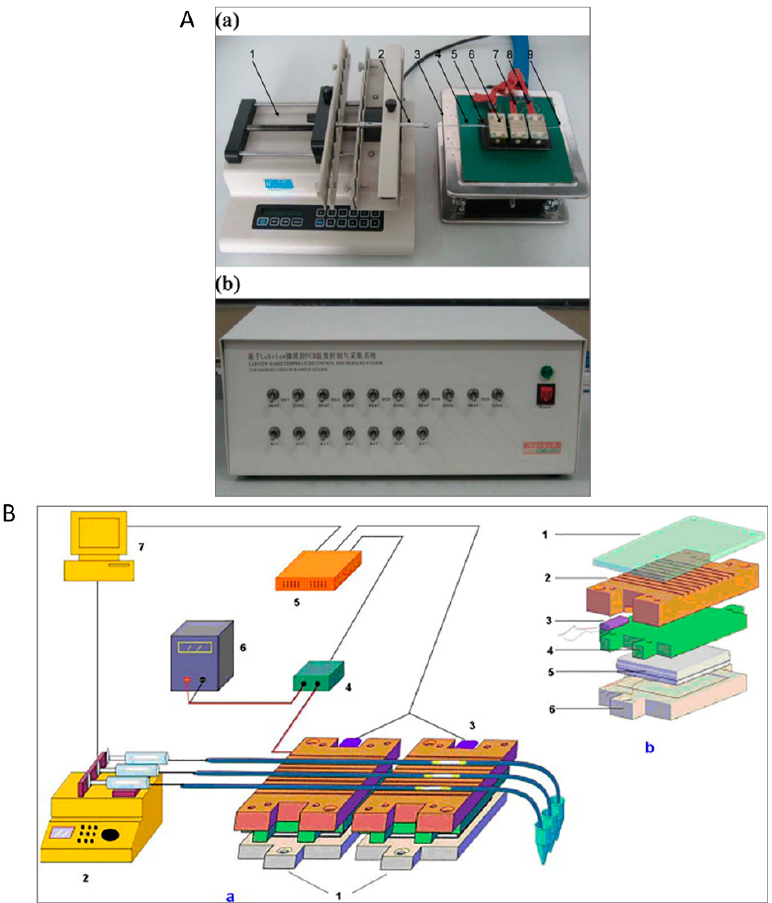
Figure 2. ( A ) Images of the oscillating-flow PCR microfluidic device. (a) The system consists of a precision syringe pump (1), glass syringe (2), lift table (3), silicon tube-based connector (4), support plate (5), copper block with a glass cover (6), thermocouple sensor (7), cartridge heater (8), and PTFE capillary tube (9). (b) The temperature control and measurement system [60]. ( B ) Schematic illustration of the oscillation-flow instrument. (a) Heating module (1), syringe pump (2), PT 100 sensor (3), relay (4), distributed multichannel controller (5), electric power source (6), and computer (7), and a magnified illustration of a heating module. (b) PC cover (1), grooved aluminum plate (2), PT 100 sensor (3), 6 aluminum plate holders (4), and Peltier heating element (5) [62]. Reproduced from the mentioned reference with permission from the related journal.